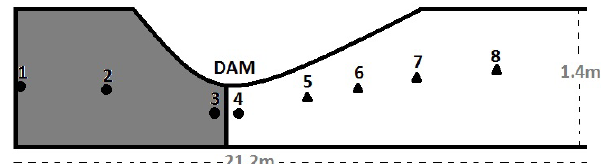
Fig. 3. Plan view flume layout for the dam break experiment of Bellos et al. (1992). Wave meter locations are displayed with circles. Pressure transducer locations are displayed with triangles (Martin and Gorelick,